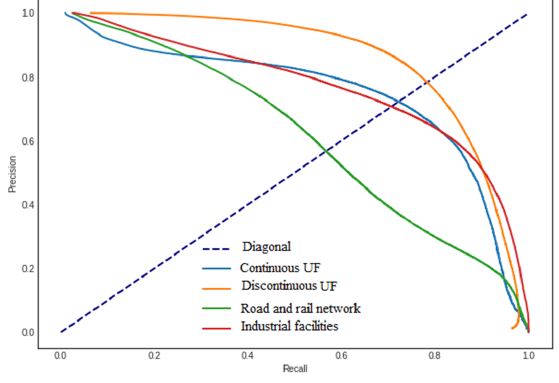
Figure 5. Precision recall curve per model.